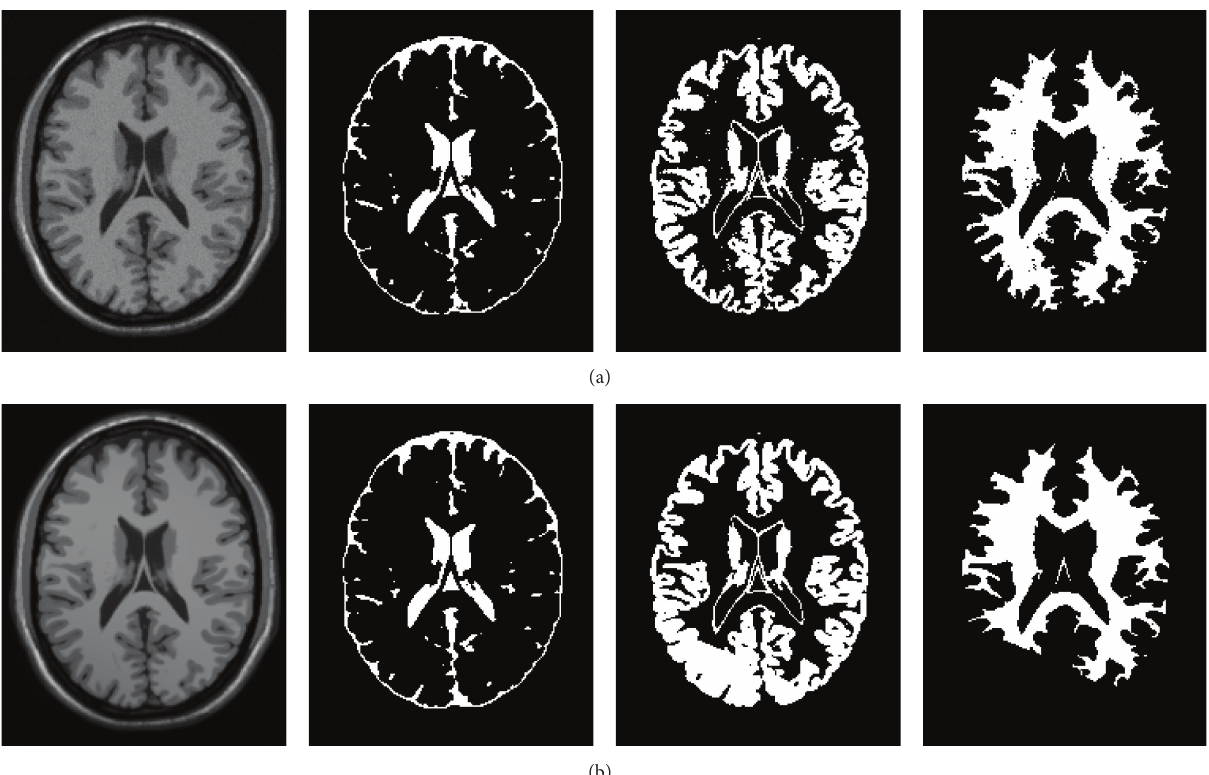
Figure 3: Result of FCM on brain MR images corrupted by noise and intensity variation. (a) Original image with 3% noise and 0% intensity inhomogeneity, Region of CSF, Region of GM, and Region of WM, respectively. (b) Original image with 0% noise and 40% intensity inhomogeneity, Region of CSF, Region of GM, and Region of WM,